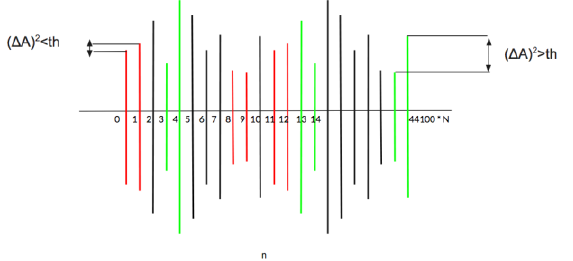
Fig. 6. Variation of contiguous samples in a stream for the algorithm optimisation